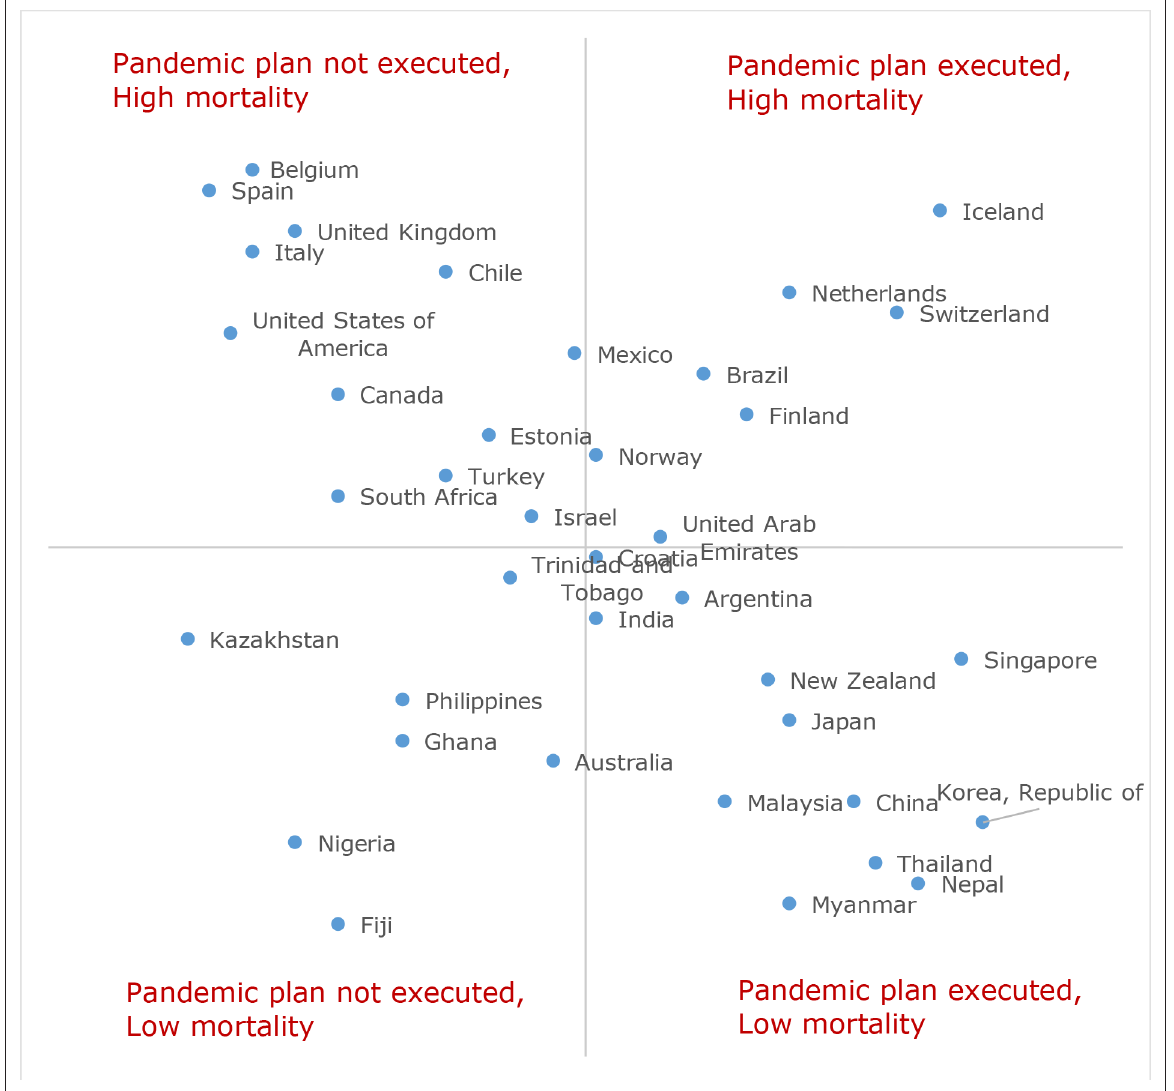
Figure 3 Relationship between pandemic plan execution and maximum COVID-19 mortality